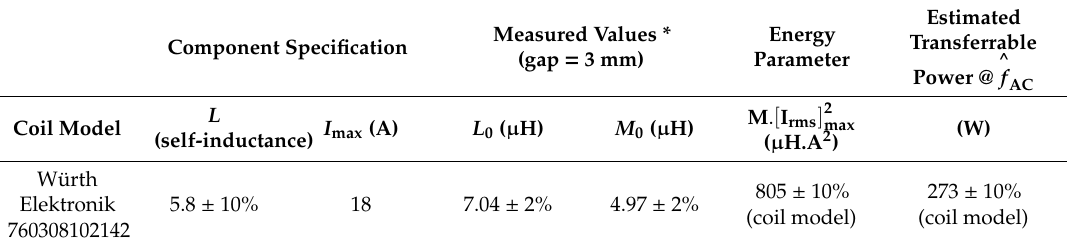
Figure 8. Q-factor of selected coil as a function of frequency of operation (from Würth Elektronik).